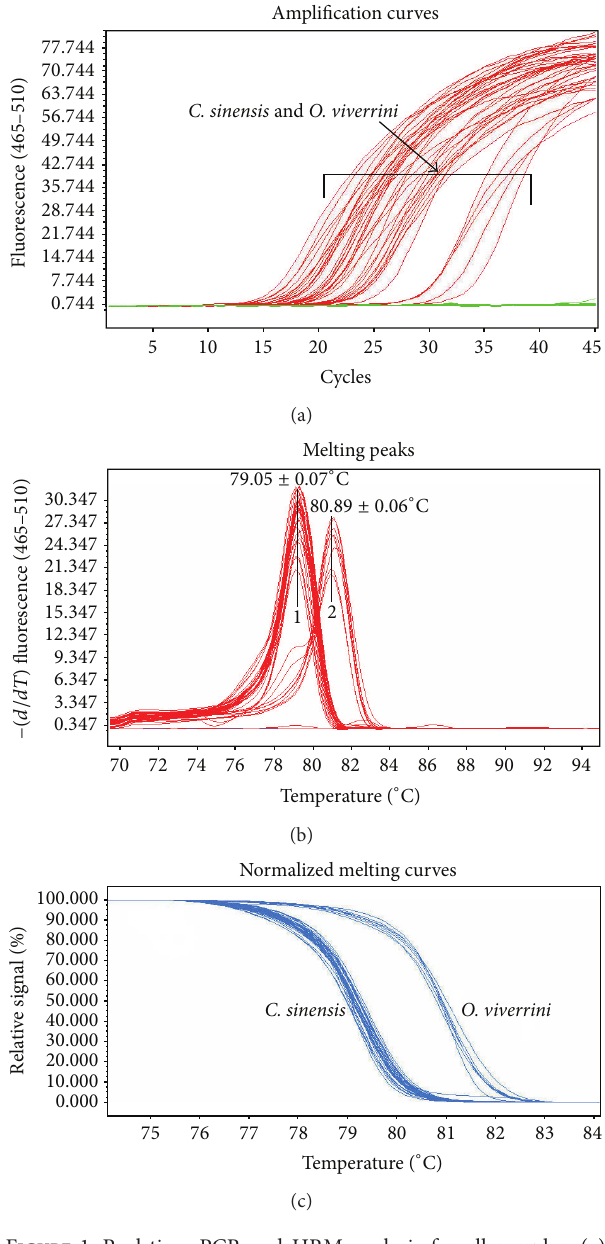
Figure 1: Real-time PCR and HRM analysis for all samples. (a) Real-time PCR amplification for all samples. All the heterologous and blank control had no amplification curve before 40 cycles. (b) Melting peaks of liver flukes 1: C. sinensis 𝑇 𝑚 , 79.05 ± 0.07 ∘ C; 2: O. viverrini , 𝑇 𝑚 , 80.89 ± 0.06 ∘ C. (c) Normalized melting curves for two liver